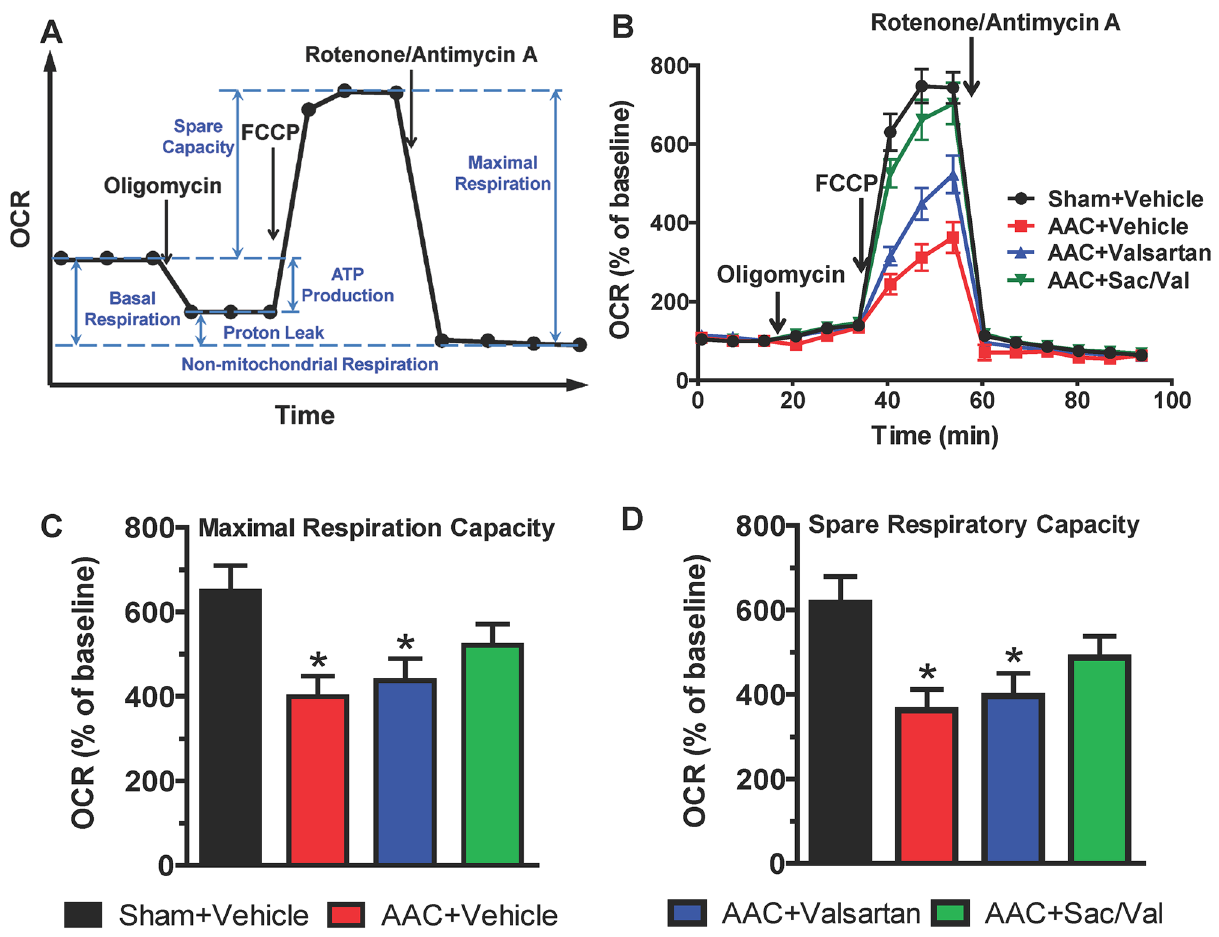
Figure 5. Sacubitril/valsartan protects ventricular myocytes from mitochondrial dysfunction in response to persistent LV pressure-overload. ( A ) Typical scheme of Seahorse XFe Cell Mito Stress Test for oxygen consumption rate (OCR) measurements in cells. ( B ) Representative OCR measured in adult rat ventricular myocytes of indicated groups after 10-week treatment. OCR were normalized to cell numbers and expressed relative to baseline. Sac/Val: sacubitril/valsartan. Mean ± SEM. n = 15–19 determinations from one rat per group. ( C ) Maximal respiration capacity and ( D ) Spare respiratory capacity that were normalized to cell numbers and expressed relative to baseline. For each rat, n = 15–19 determinations were averaged as one biological sample. Mean ± SEM. N = 6–7 rats per group. * P < 0.05 versus Sham +